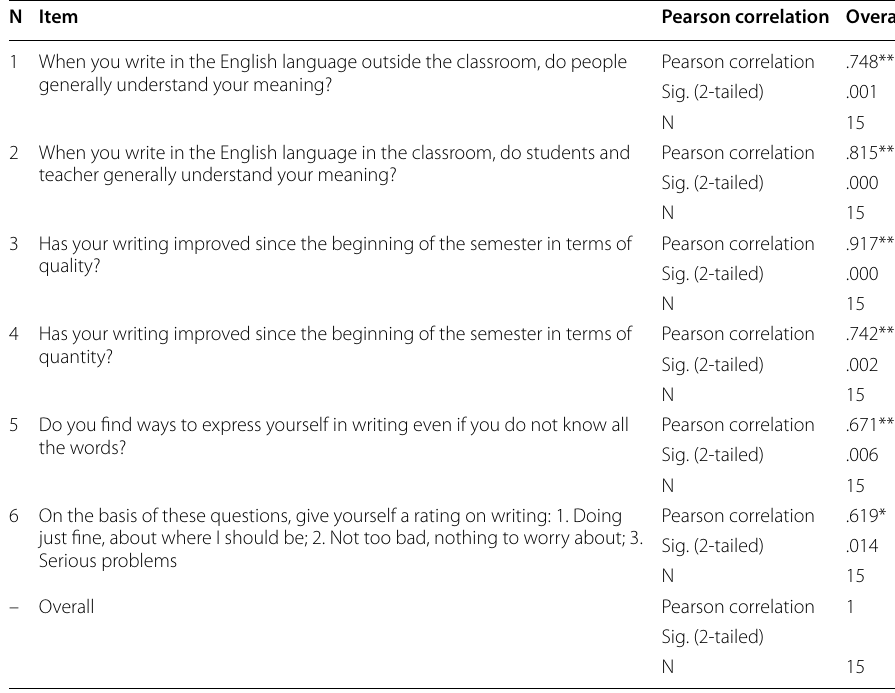
Table 1 Self‑evaluation questionnaire’s Pearson correlation coefficient